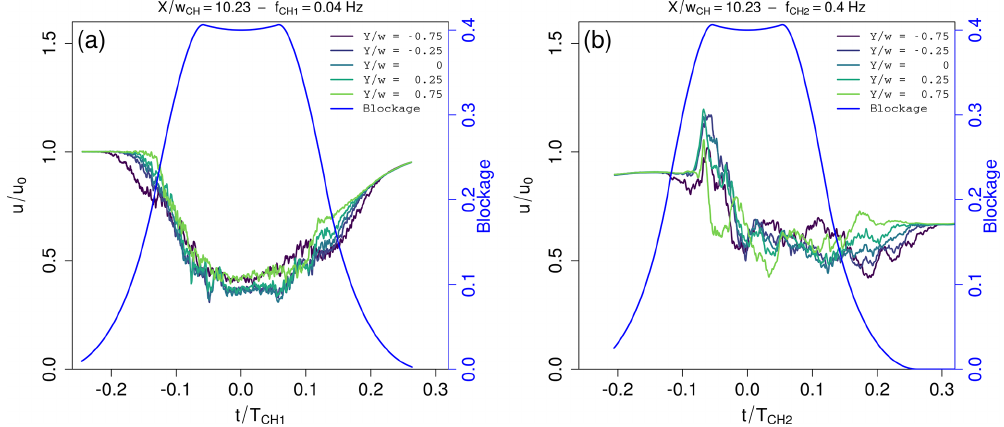
Figure 13. Span-wise evolution of the smoothed average inverse gust at X/w CH = 10 . 225 with respect to the chopper blade position. The inverse gust as measured by the respective sensor is plotted over the normalized time, where t/T CH = 0 indicates that the chopper blade is aligned horizontally in the inlet, and the blockage is added in blue with the blue axis on the right side. The chopper frequencies are